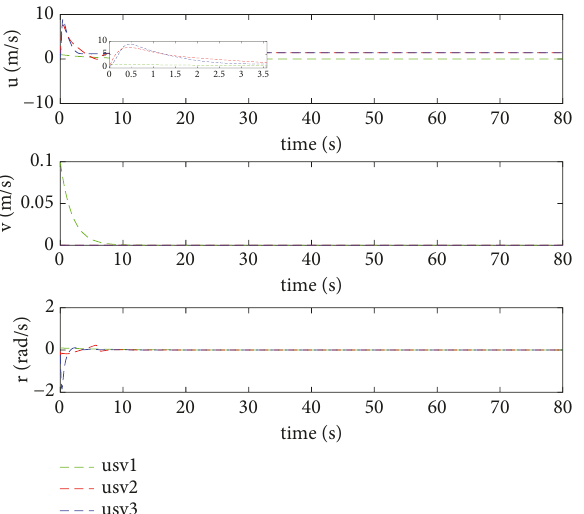
Figure 6: The velocity of USV with backstepping method.